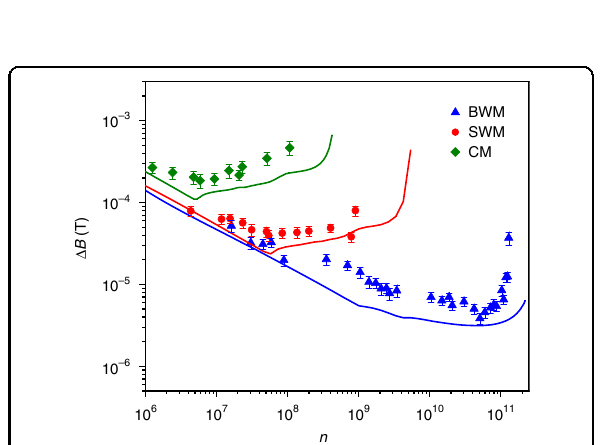
Fig. 5 Precision of magnetic sensing for CM, SWM, and BWM schemes. The precision Δ B obtained using CM, SWM, and BWM schemes are plotted versus the incident photon number n . CM and SWM achieve their best precisions of 2.2 × 10 − 4 T and 3.63 × 10 − 5 T with 5.9 × 10 6 and 9 : 7 ´ 10 7 photons, respectively. Afterward, the precisions degrade since DSE occurs. Because of the extinction effect, the precision of BWM keeps to be improved up to 5 : 08 ´ 10 10 photons and the best precision is 4 : 05 ´ 10 (cid:2) 6 T . The theoretical precisions calculated from the FI for CM, SWM, and BWM schemes are shown as the solid lines in the same color with their respective experimental results